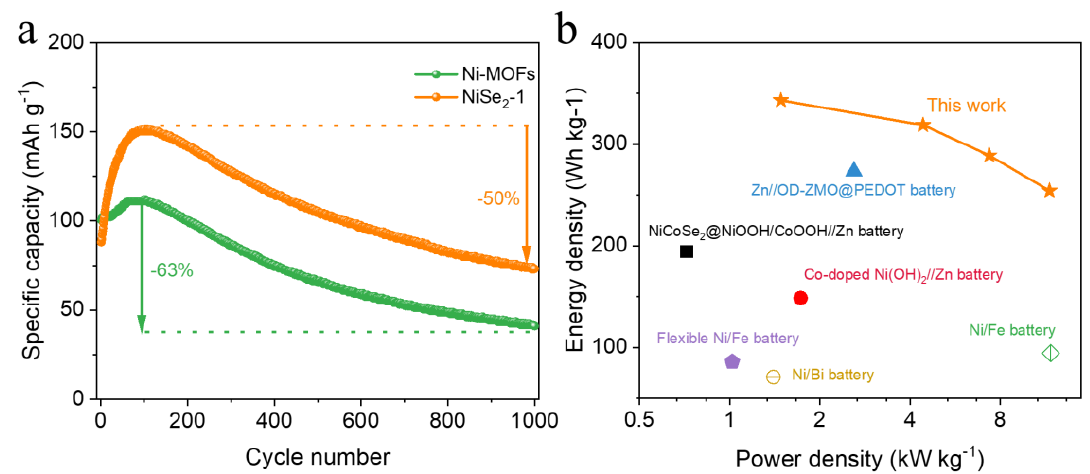
Figure 5. ( a ) Long-term cycling stability of Ni-MOFs and NiSe 2 − 1 at 8 A g − 1 over 1000 cycles. ( b ) Ragone plot of the NiSe 2 − 1//Zn battery and other reported rechargeable batteries